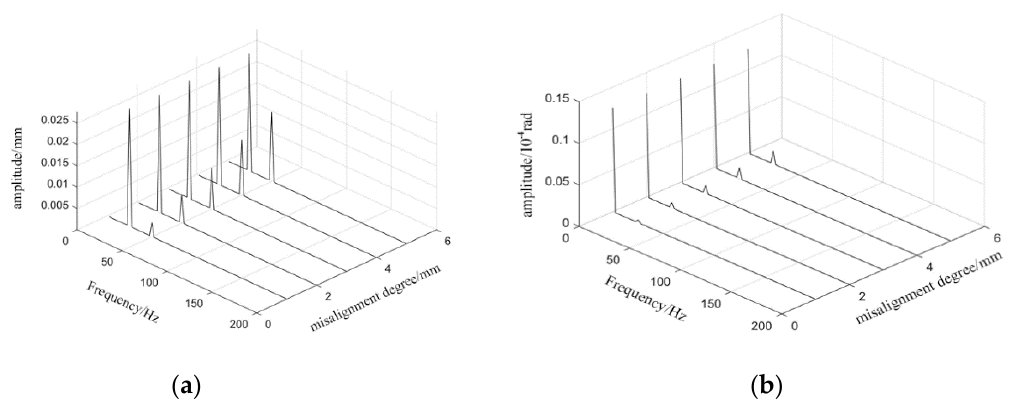
Figure 6. Vibration response frequency waterfall diagram with misalignment fault: ( a ) Radial vibration; ( b ) Torsional vibration.